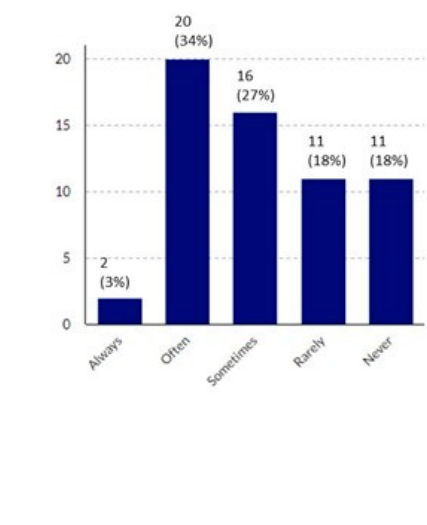
Figure 3. Methods of fluid responsiveness assessment utilized in the ICU environment.